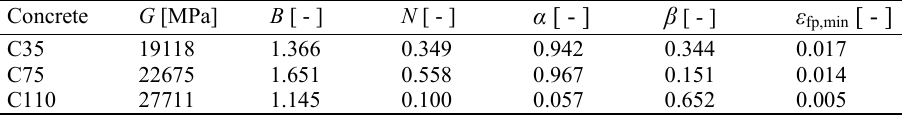
Fig. 5. Setup of 2D axisymmetric finite element simulations for (a) cylinder compression test and (b) ballistic impact tests, and (c) fringe plot of the volumetric strain during impact simulation of a C75 slab. Table 2. Material constants for MHJC model obtained by inverse